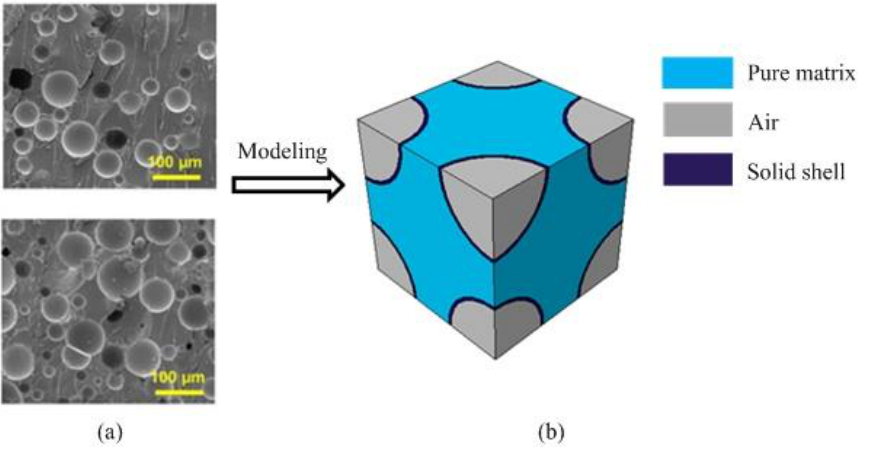
Figure 2. ( a ) SEM images of composites with different HGB contents (reprinted with permission from ref. [15]. Copyright 2020 Elsevier) and ( b ) the corresponding theoretical RVE 1 model with matrix, shell and air.